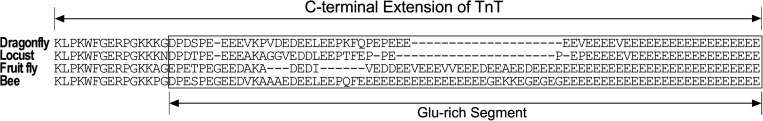
Glu-rich C-terminal extension of insect TnT. Amino acid sequences encoded by exon 11 or exon 12 of representative insect TnT genes are aligned to identify residue similarity and to illustrate the insect-specific C-terminal extension enriched with Glu residues. The Glu contents appear positively correlating to the frequencies of wing beat of these species (Snelling et al., 2012). GenBank accession numbers of the sequences used are: Dragonfly TnT, AAD33604.1; locust TnT, AVCP010016941; Drosophila TnT, NP_525088; Bee TnT, NP_001035348.1.